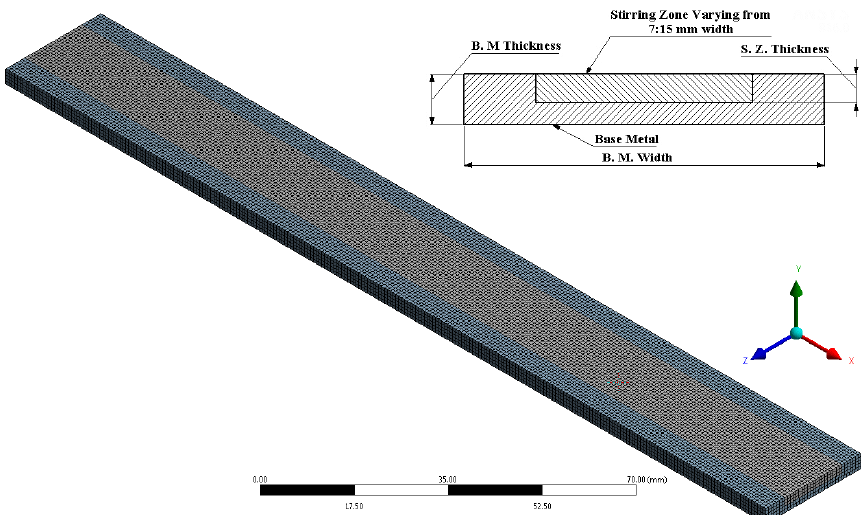
Figure 4. Meshing methods for surface composite processed beam.